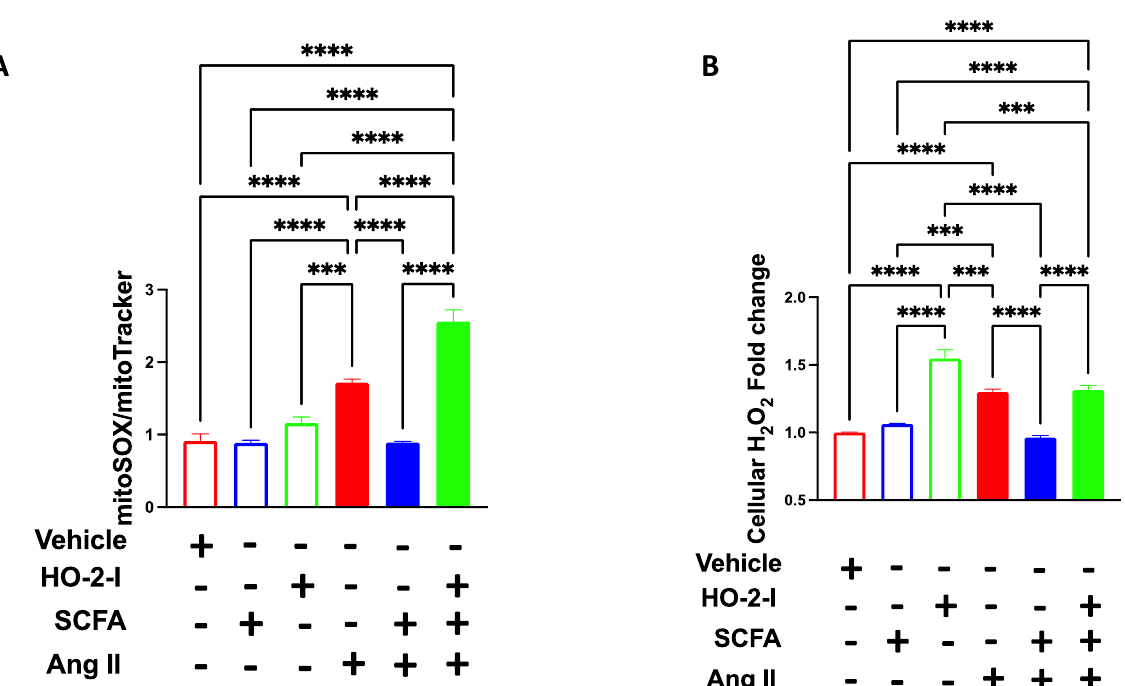
Figure 5. SCFAs rescued Ang-II-induced membrane potential damage by mediating HO-2. TMRM fluorescence integrated density ( A ) and representative images ( B ) showing that Ang-II- induced membrane potential hypopolarization in brain microvascular endothelial cells was reversed by the SCFAs/HO-2 axis. * p < 0.05; ** p < 0.01; **** p < 0.0001. N = 3–5. SCFAs: short-chain fatty acids; Ang II: angiotensin II; HO-2 I: heme oxygenase 2 inhibitor; and TMRM: Tetramethyl rhodamine, Methyl Ester, Perchlorate.